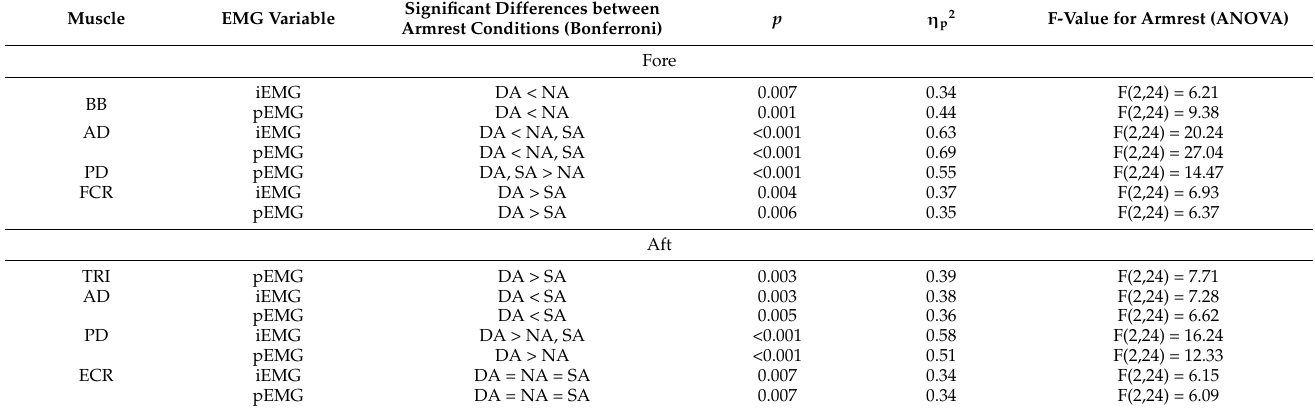
Table 5. Summary of statistically significant effects ( p < 0.01) for muscle activation results between armrests (DA = dynamic armrest, SA = stationary armrest, and NA = no armrest) and movement direction (fore, aft, inward, and outward) for each muscle group (BB = biceps brachii, TRI = triceps brachii, AD = anterior deltoid, PD = posterior deltoid, UT = upper trapezius, ECR = extensor carpi radialis, FCR = flexor carpi radialis). EMG—integrated EMG; pEMG—peak EMG. N = 15, except for the UT data where N =